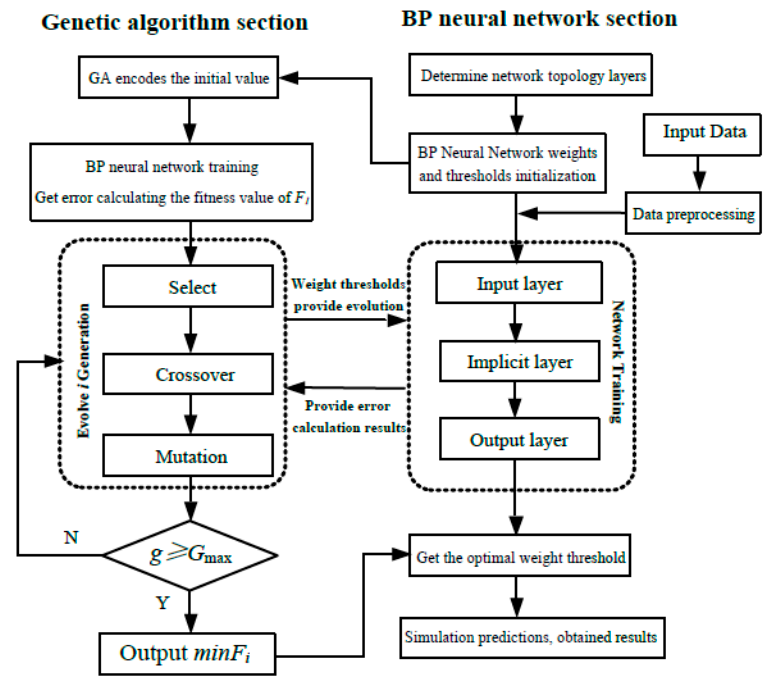
Figure 4. GA-BP algorithm fl ow chart .